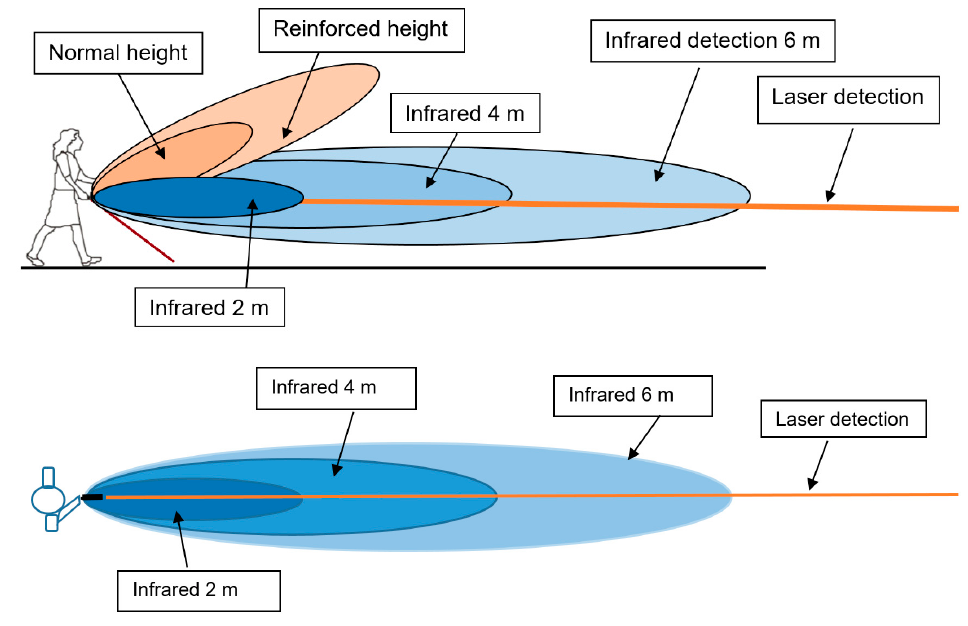
Figure 1. Illustration of Tom Pouce III detection ranges. Top panel : lateral view of the protection area of the Tom Pouce. Bottom panel : top view of the protection area.